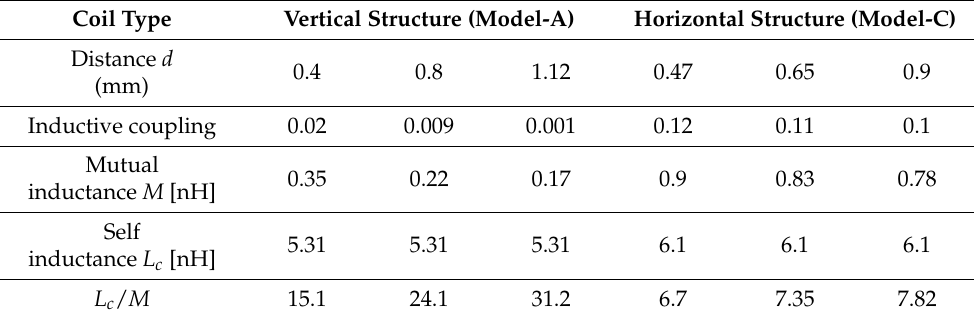
Table 3. Influence of the inductance under different distances d with the FEA method.